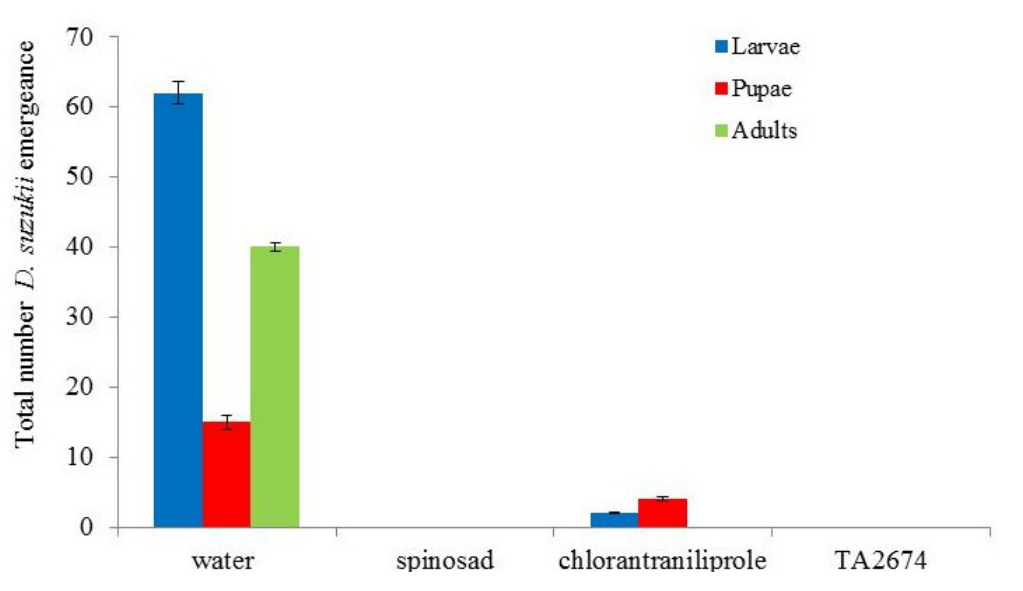
Figure 9. Impact of pre-treating blueberries with chemical insecticides on subsequent Drosophila suzukii infestation and development (assessed after 10 days incubation at 25